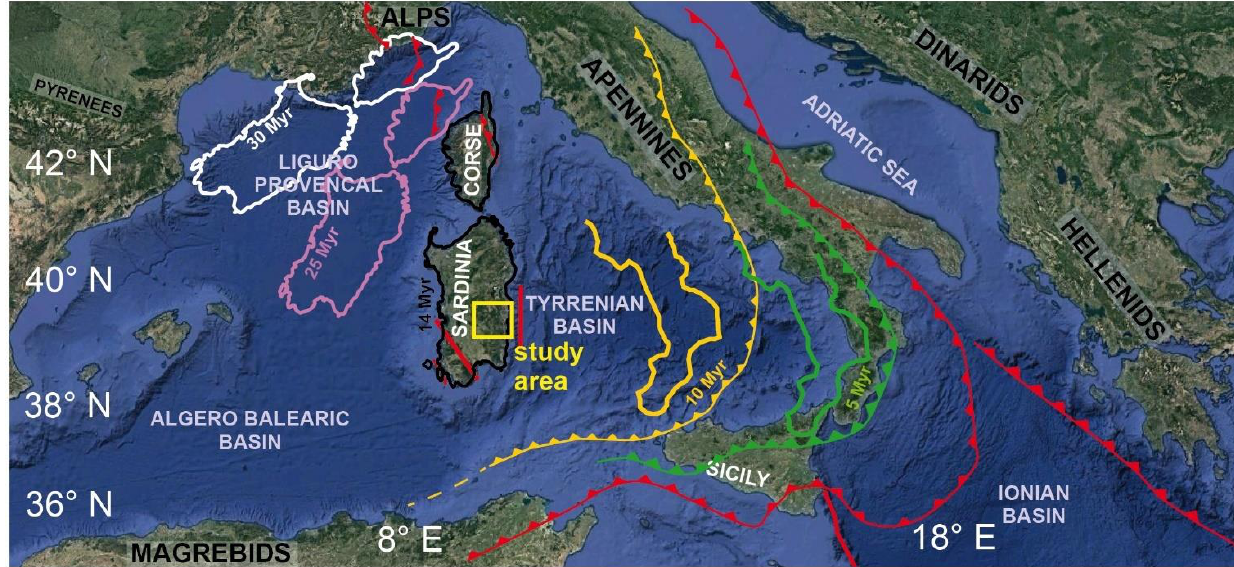
Figure 1. Geographical location and structural features of the study area, modified after [8]; red lines represent thrust fronts; white lines are the Sardinian – Corse Block translation at 30 Ma; the pink line represents the Sardinian – Corse Block translation at 25 Ma; the yellow line represents the Calabrian block translation at 10 Ma; the green line represents the Calabrian block translation at 5 Ma [2].